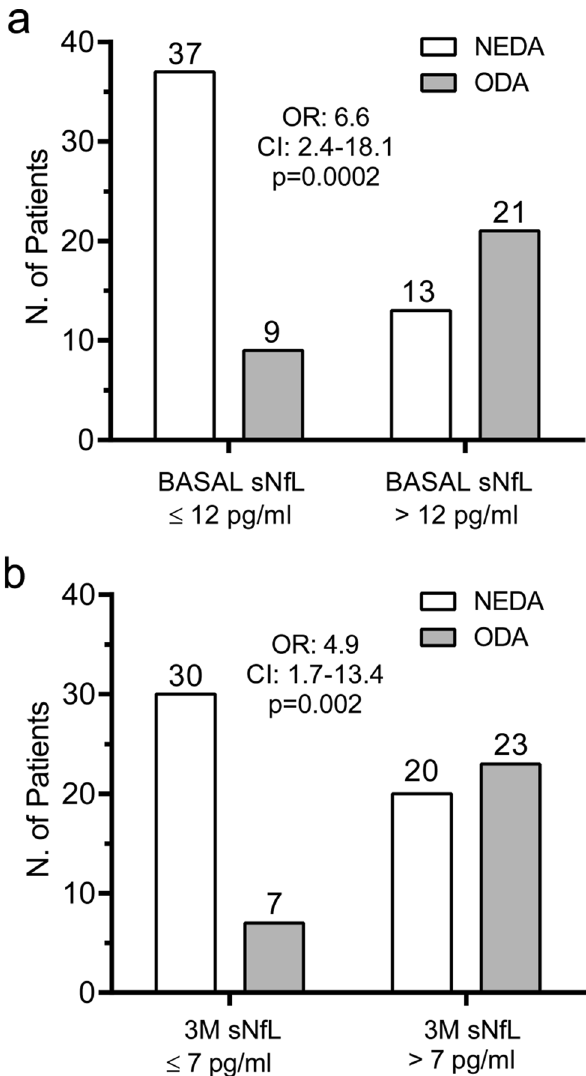
Figure 3. Serum neurofilament light chain (sNfL) values identify optimal responders to dimethyl fumarate (DMF) treatment. Number (N.) of relapsing–remitting multiple sclerosis patients achieving NEDA (white rectangle) or ODA (grey rectangle) status after 12 months of DMF treatment, depending on their baseline (basal) sNfL ( a ) or their 3-months (M) sNfL levels ( b ). CI 95% confidence interval, NEDA no evidence of disease activity, ODA ongoing disease activity, OR odds